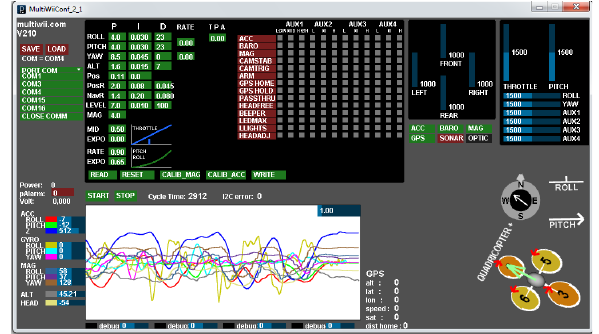
Figure 2. MultiWii-Software Interface